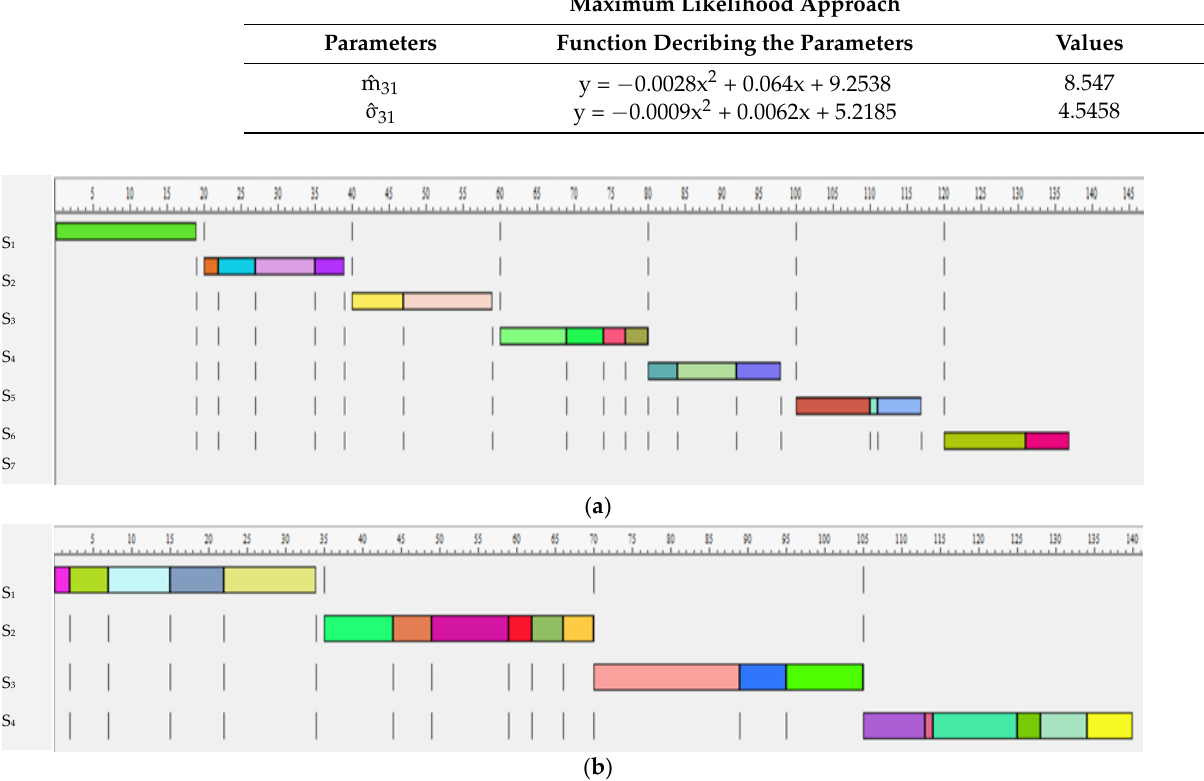
Figure 6. Disassembly tasks assigned to stations according to the decreasing demand and: ( a ) cycle time equals 20 min; ( b ) cycle time equals 35 min.